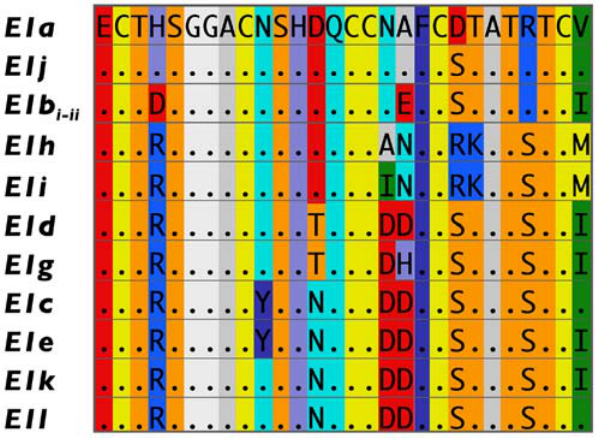
Figure 2. Predicted amino acid sequences of the toxin coding region of alleles of conotoxin locus E1 of Conusebraeus . Amino acids are provided as single letter codes; dots are used to indicate identity to the amino acid of the first sequence given. To illustrate radical amino acid substitutions, amino acids with similar chemical properties are provided in similar background colors (coloring based on the ‘amino’ scheme utilized in Jmol, a Java viewer for chemical structures (http://www.jmol.org/)). Amino acid sequences of E1b i and E1b ii were combined because they exhibit no nonsynonymous substitutions with the toxin coding region.